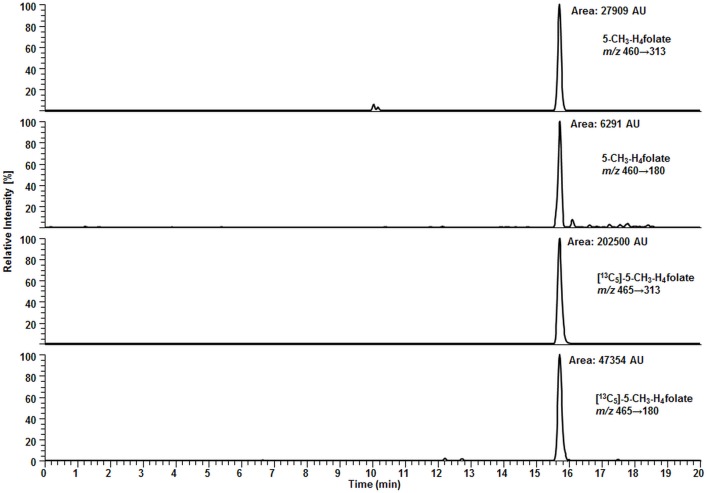
Liquid chromatography–tandem mass spectrometry chromatogram of calibrator 14 (Table 2).